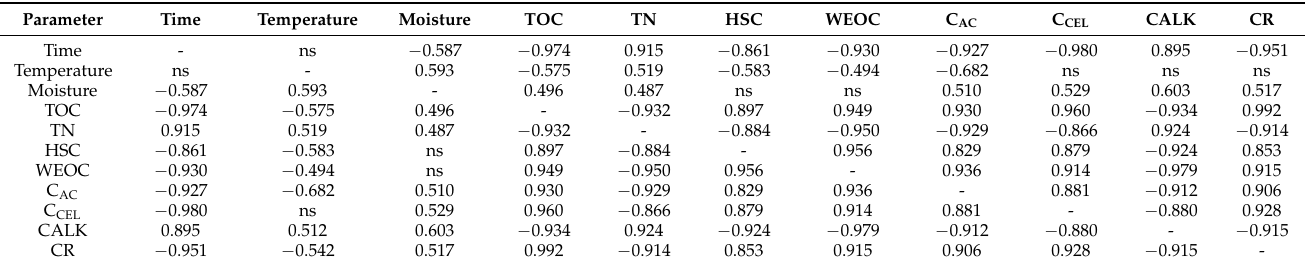
Table 1. Correlation coefficients between the investigated chemical properties and the basic compost- ing parameters (time, temperature moisture) in the studied samples.